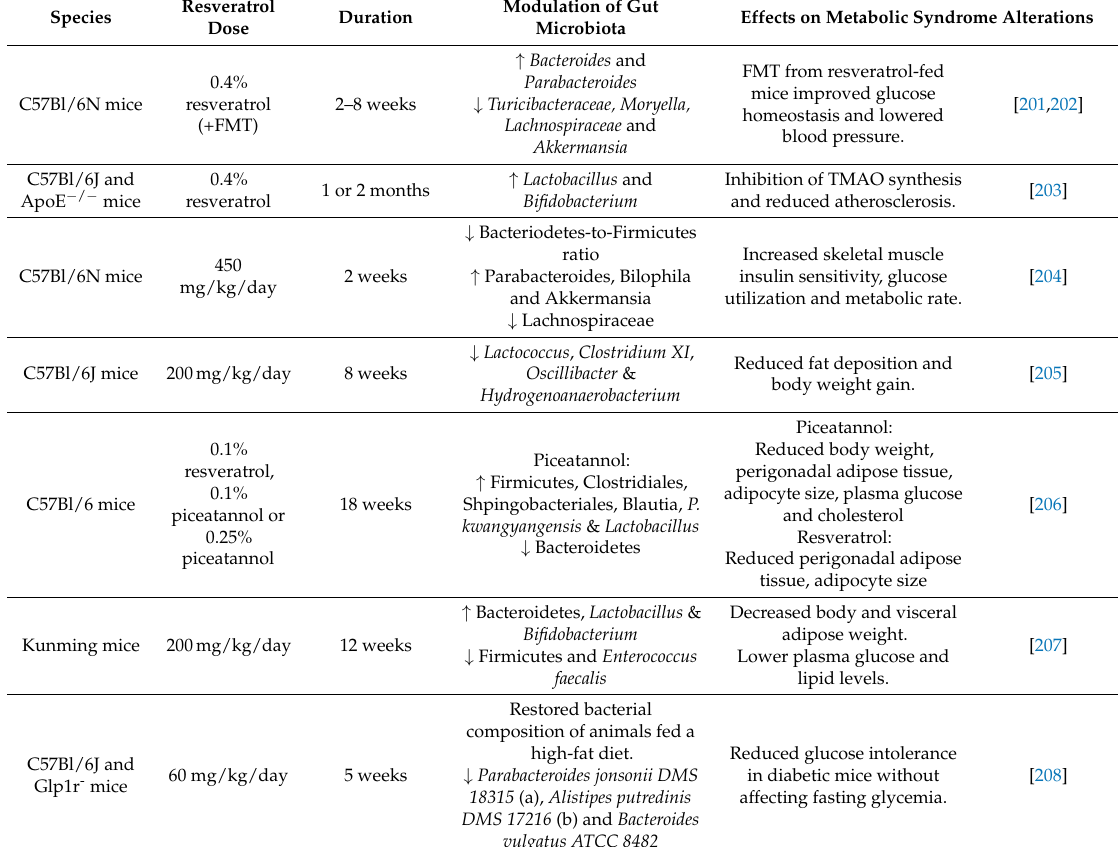
Table 1. Review of studies analyzing the effect of resveratrol on gut microbiota